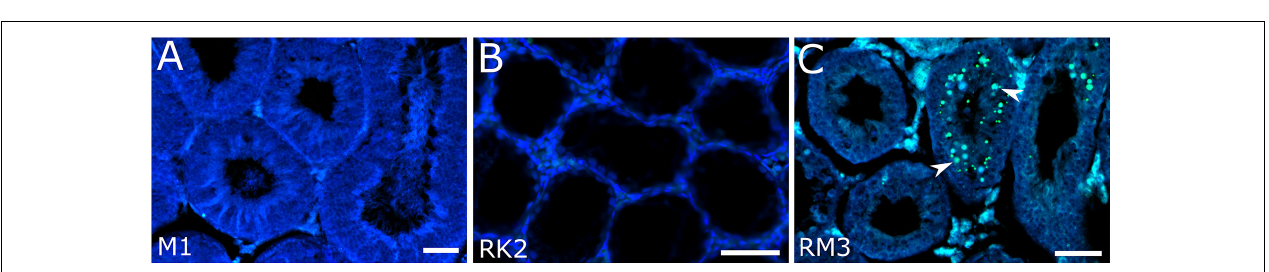
male RM3, we observed erratic syncytial spermatid balls; in male RM2, we detected a seminoma in the germinal epithelium of the seminiferous tubules ( Figure 2G